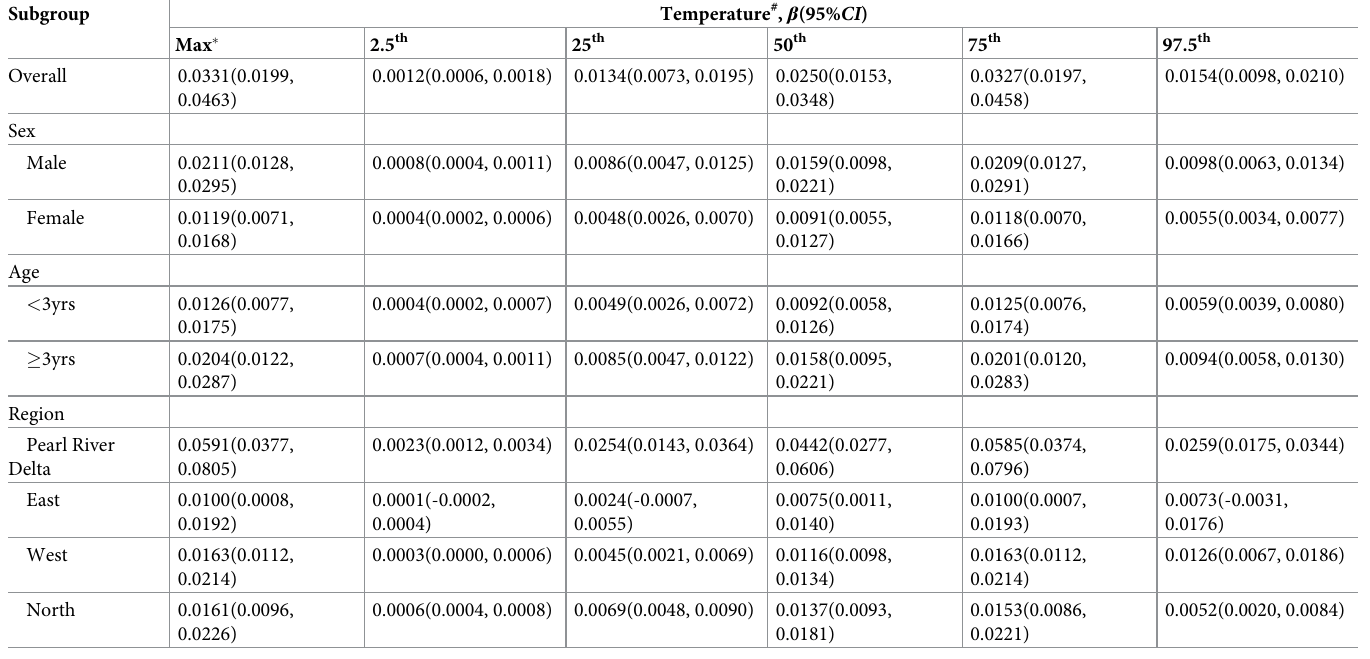
Table 2. Regression coefficients of temperature on HFMD